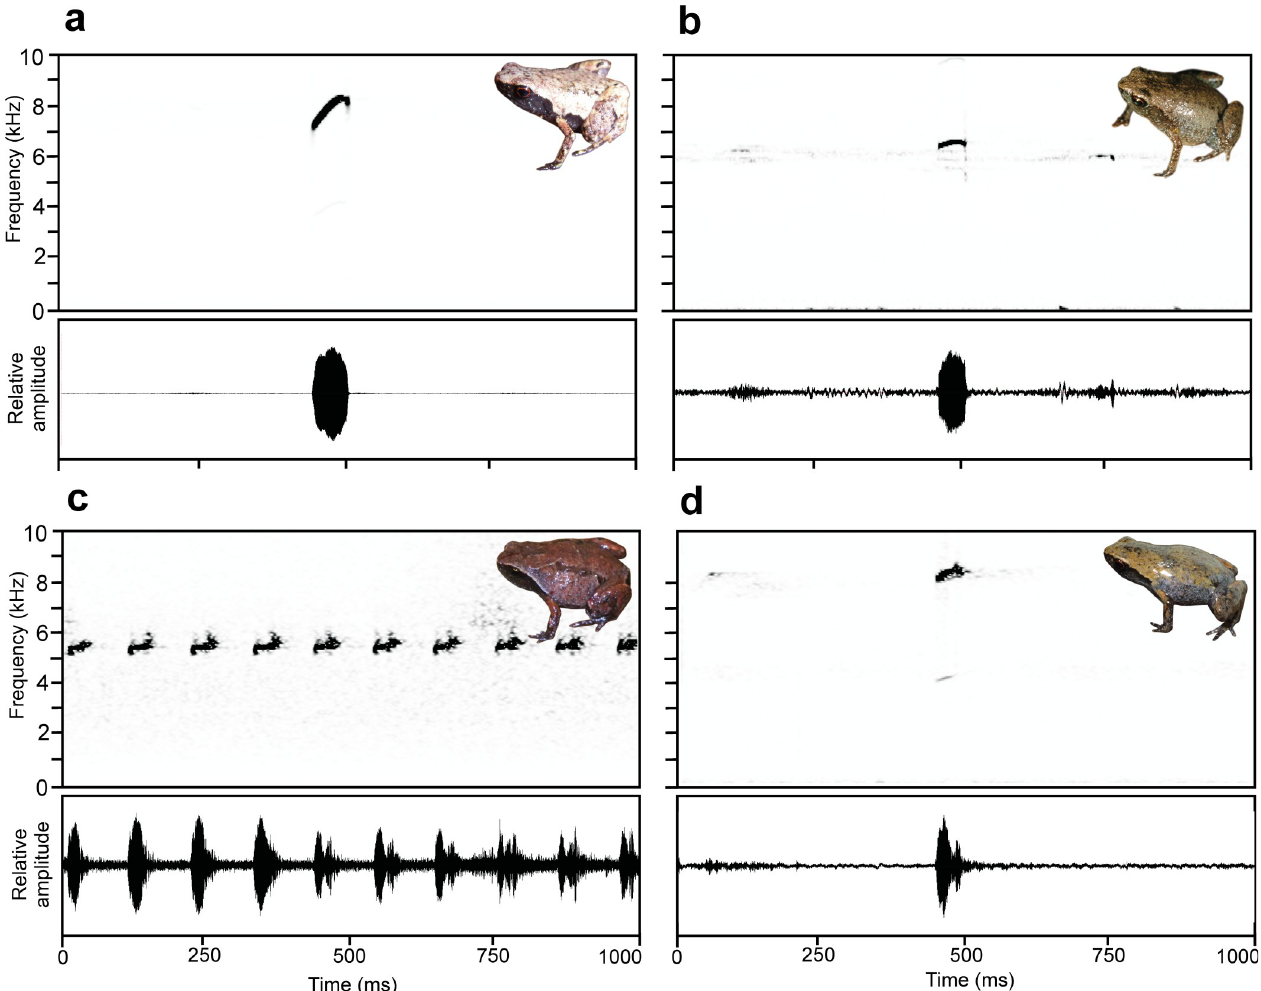
Fig 5. One-second spectrograms and oscillograms of the calls of the new species described here. Insets represent the respective species but not the calling specimens. (a) Mini mum gen. et sp. nov., paratype ZMB 81993 from Manombo, (b) Mini scule gen. et sp. nov., ZSM 265/2018 from Sainte Luce, (c) Rhombophryne proportionalis sp. nov., part of a call (note series) of a specimen from Bepia campsite, Tsaratanana (not collected), (d) Anodonthyla eximia sp. nov., specimen not collected, from Maharira (Ranomafana).